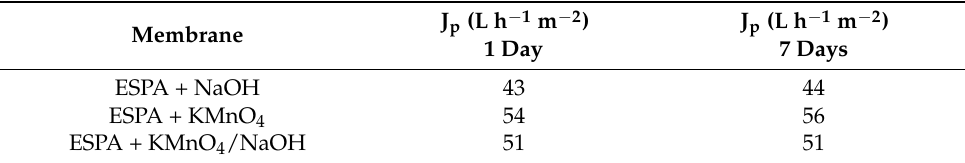
Table 4. WPPA flux of regenerated membranes.